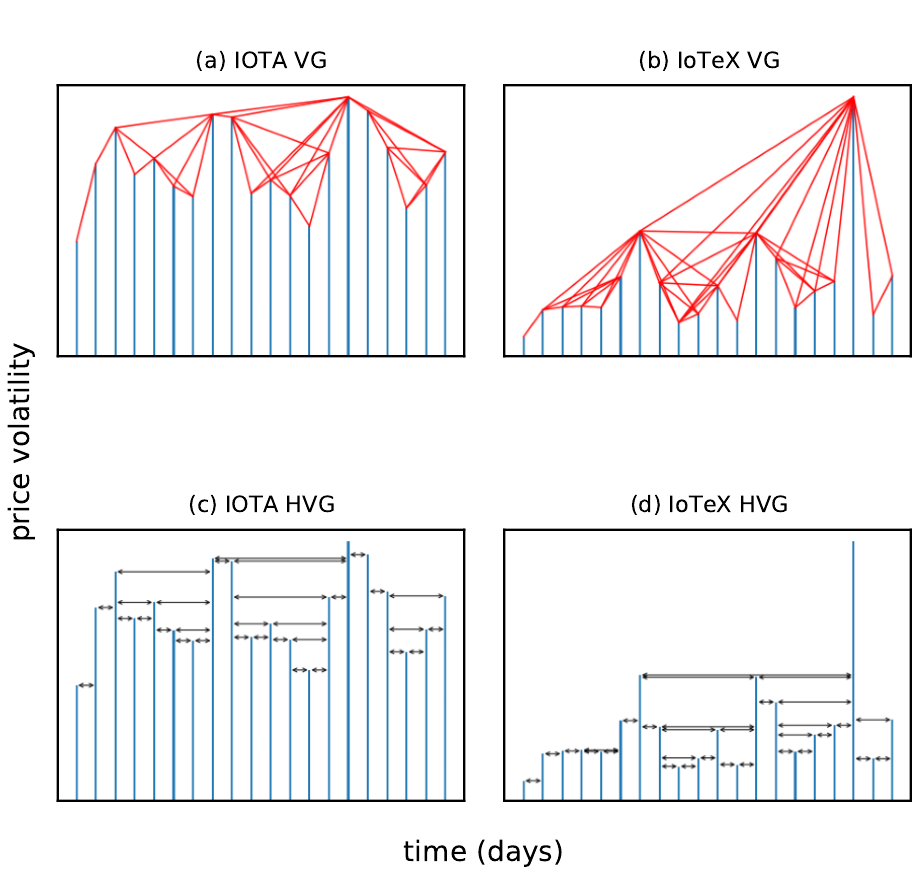
Figure 2. Visibility and horizontal visibility graphs for IOTA and IoTeX price volatility. Subplots ( a , b ) display the visibility graph derived from the daily volatility time series for IOTA and IoTeX, respectively (last 20 days of the dataset). Subplots ( c , d ) display the horizontal visibility graph derived from the daily volatility time series for IOTA and IoTeX, respectively (last 20 days of the dataset). The depiction of these graphs is the outcome of our own Python